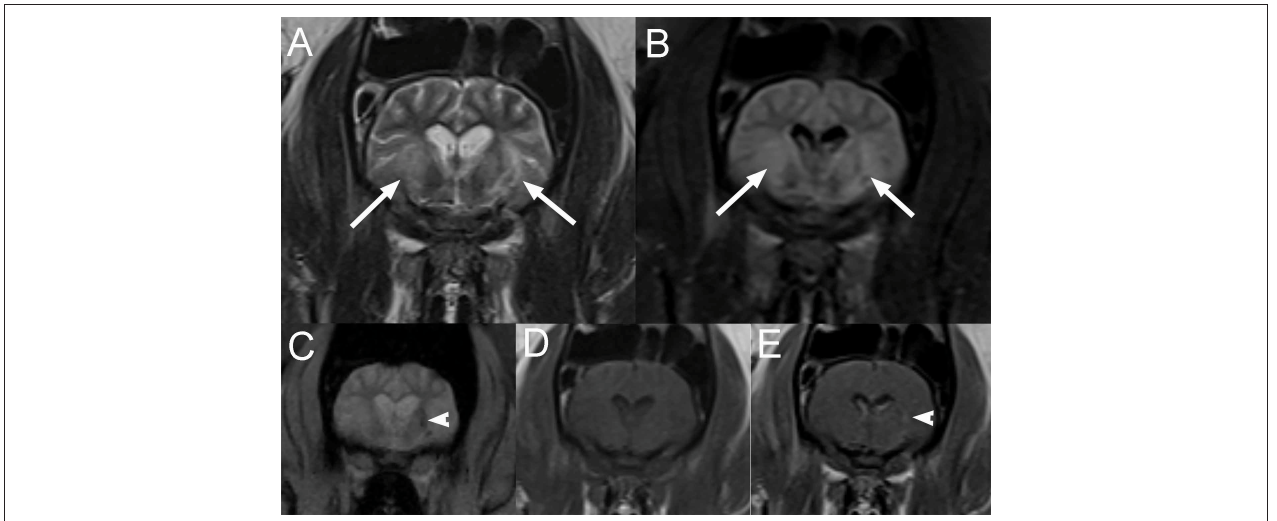
FIGURE 8 | Transverse T2W (A) , T2-FLAIR (B) , T2*-weighted gradient recovery echo (T2*GRE) (C) , pre (D) , and post contrast (E) T1W images in a 7-year-old pig presented for progressive ataxia and mentation change and ultimately diagnosed with moderate multifocal acute and chronic encephalomalacia with thrombi (infarcts) secondary to endocarditis (Case 8). Note the poorly marginated heterogeneous T2W and T2-FLAIR (A,B) hyperintense lesions compared to white matter in the thalamus (arrows). Several of the lesions display susceptibility artifacts on T2*-GRE ( C ; arrowhead), consistent with hemorrhage and/or intravascular thrombi. These lesions are isointense to slightly hypointense to the white matter on T1W images (D) with faint and progressive enhancement seen within the left thalamic lesions ( E ; arrowhead).